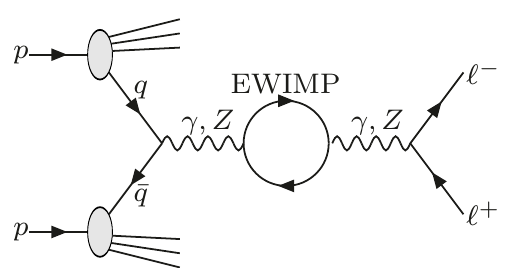
Figure 1 . Radiative correction from the electroweakly interacting massive particle